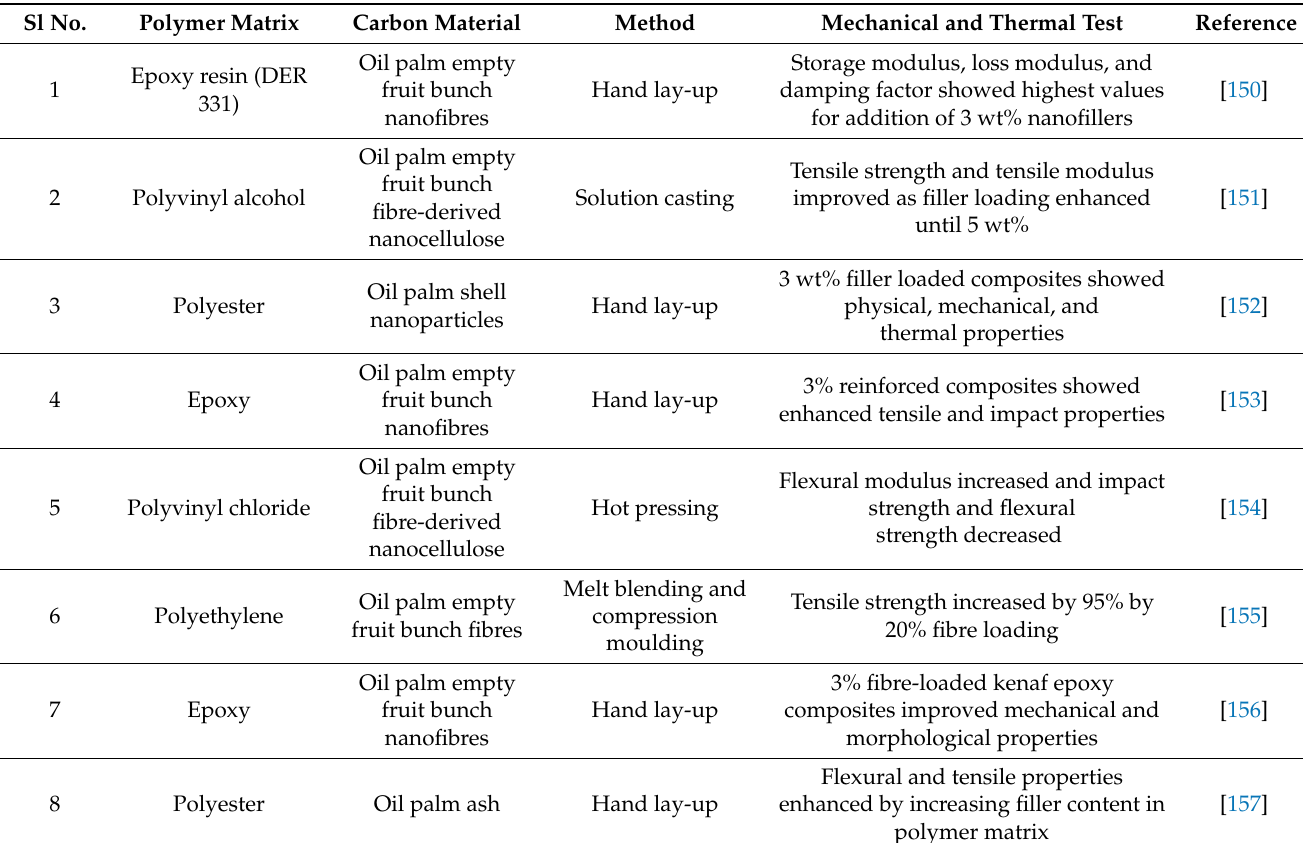
Table 15. Synthesis and characterization of oil palm